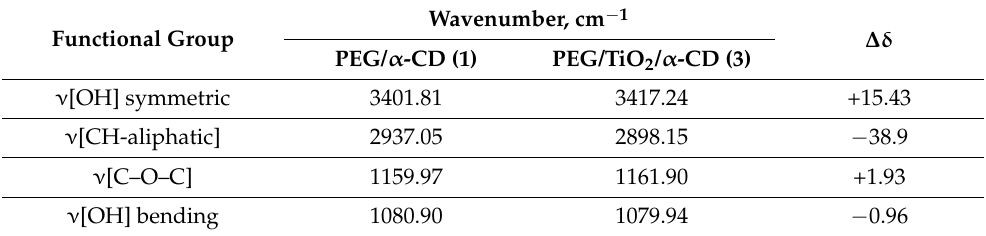
Table 5. FT-IR difference between pseudopolyrotaxane ( 1 ) and pseudopolyrotaxane composite ( 3